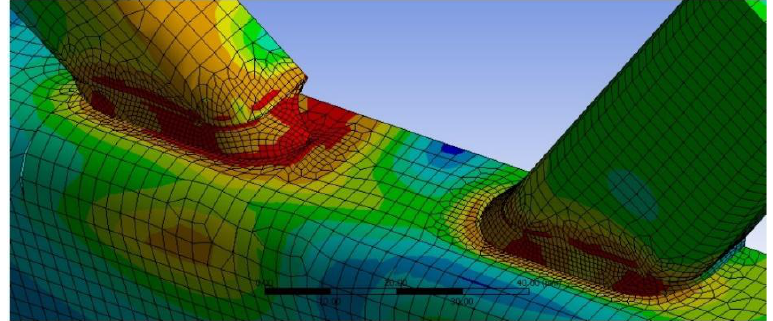
Figure 13. Failure in joint KB1 with a semi-circular hole and brace angles of 45°.